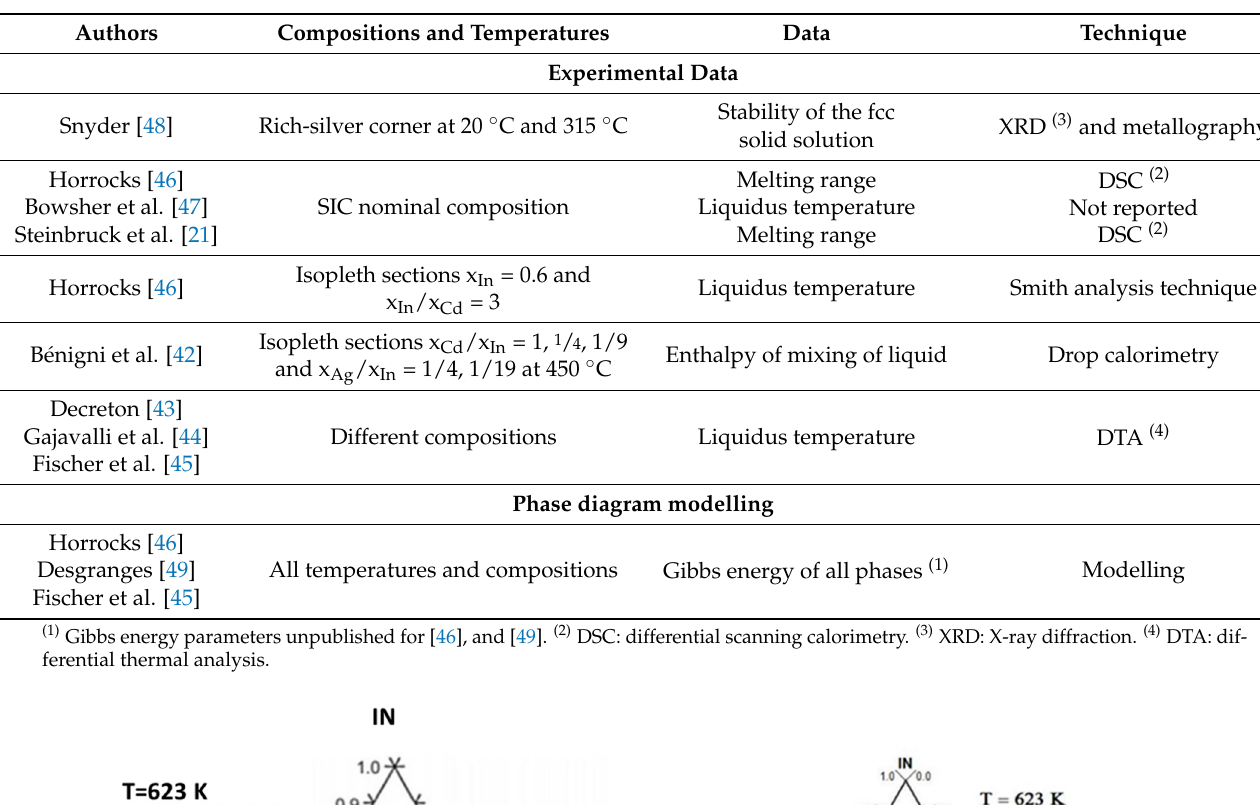
Table 1. Main thermodynamics information in the Ag-In-Cd ternary system.